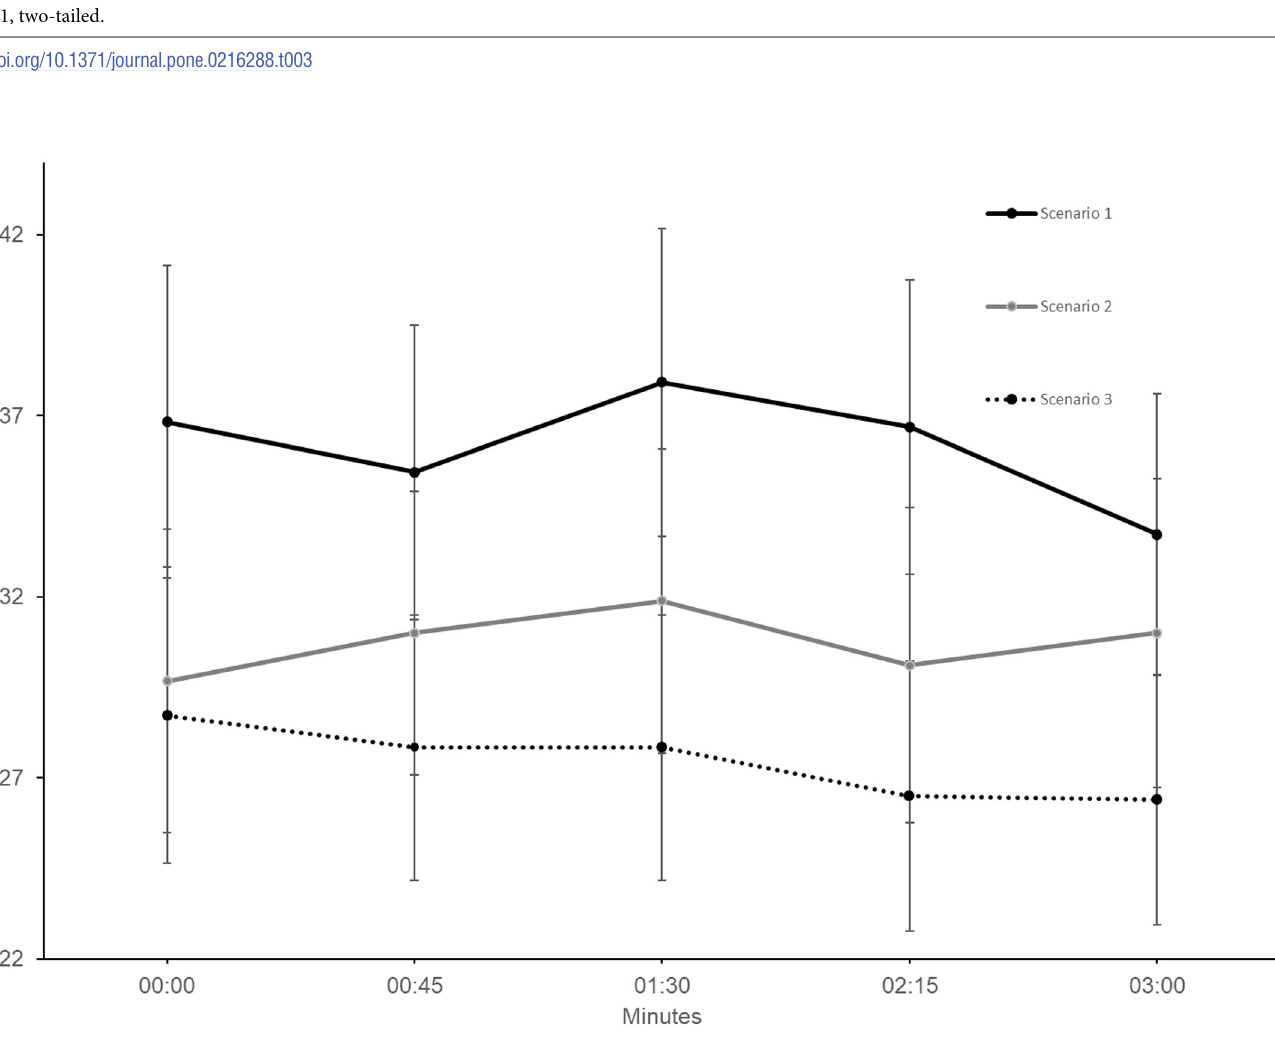
PLOS ONE | https://doi.org/10.1371/journal.pone.0216288 May 31,